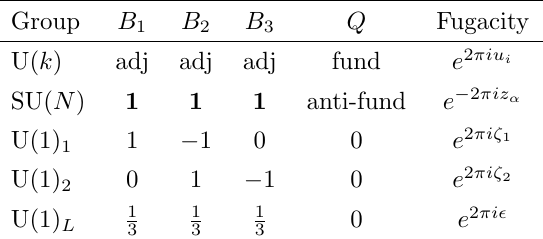
Table 1 : Gauge, (cid:13)avour and R- symmetry groups, charges of chiral multiplets and asso- ciated fugacities (exponentials of chemical potentials). The multiplets B have vector-like I R-charge 2 so that the left-moving R-charge is 1 . The (cid:13)avour symmetry fugacities are 3 3 constrained to satisfy Q e (cid:0) 2 (cid:25)iz (cid:11) = (cid:11)